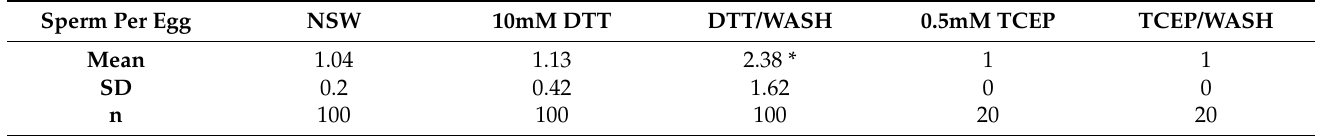
Table 2. Number of egg-incorporated sperm inside the P. lividus eggs fertilized in various treatments. Sperm Per